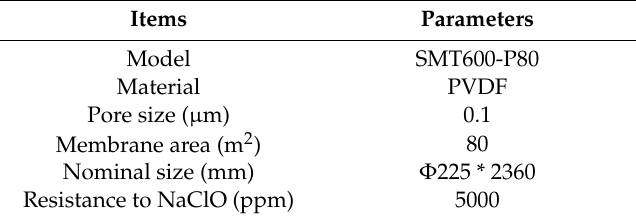
Table 4. Main pollutant indicators of the influent and the e ffl uent from WWTP before